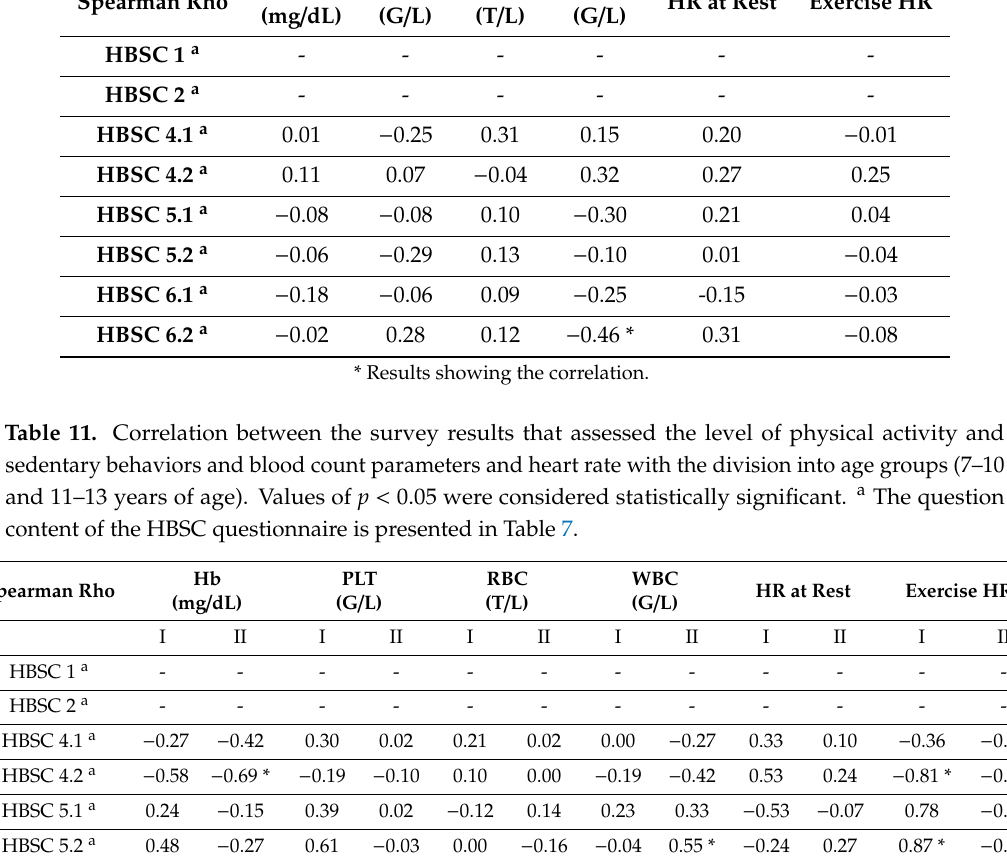
* Results showing correlation. Group I = children aged 7–10; group II = children aged 11–13. The analysis of the relationships between the level of physical activity and the results obtained in the exercise stress test with the division into age groups (7–10 and 11–13 years of age) did not show statistically significant observations (Table